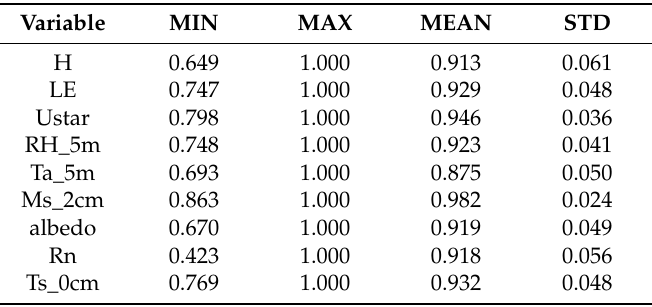
Table 6. Statistics of the entropy for each